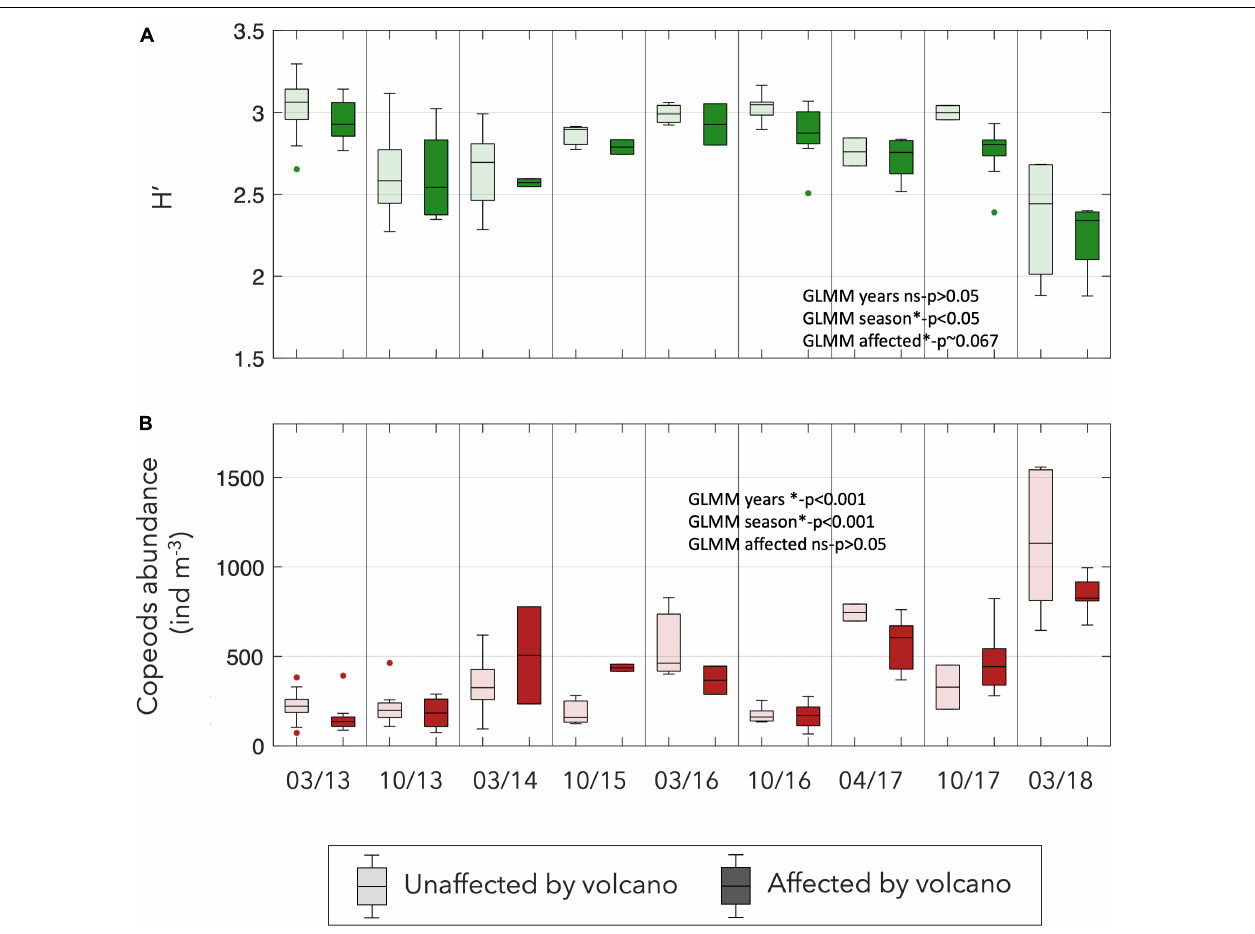
FIGURE 8 | Box-plots of the (A) Shannon diversity index of the copepods and (B) total abundance of copepods at each survey (ind m − 3 ) considering affected and unaffected stations by the influence of the volcano.